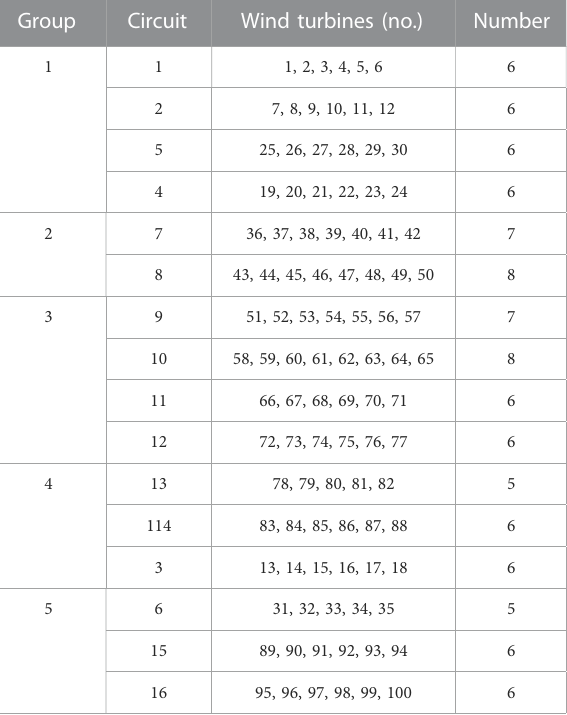
TABLE 4 Grouping of wind farms. Group Circuit Wind turbines